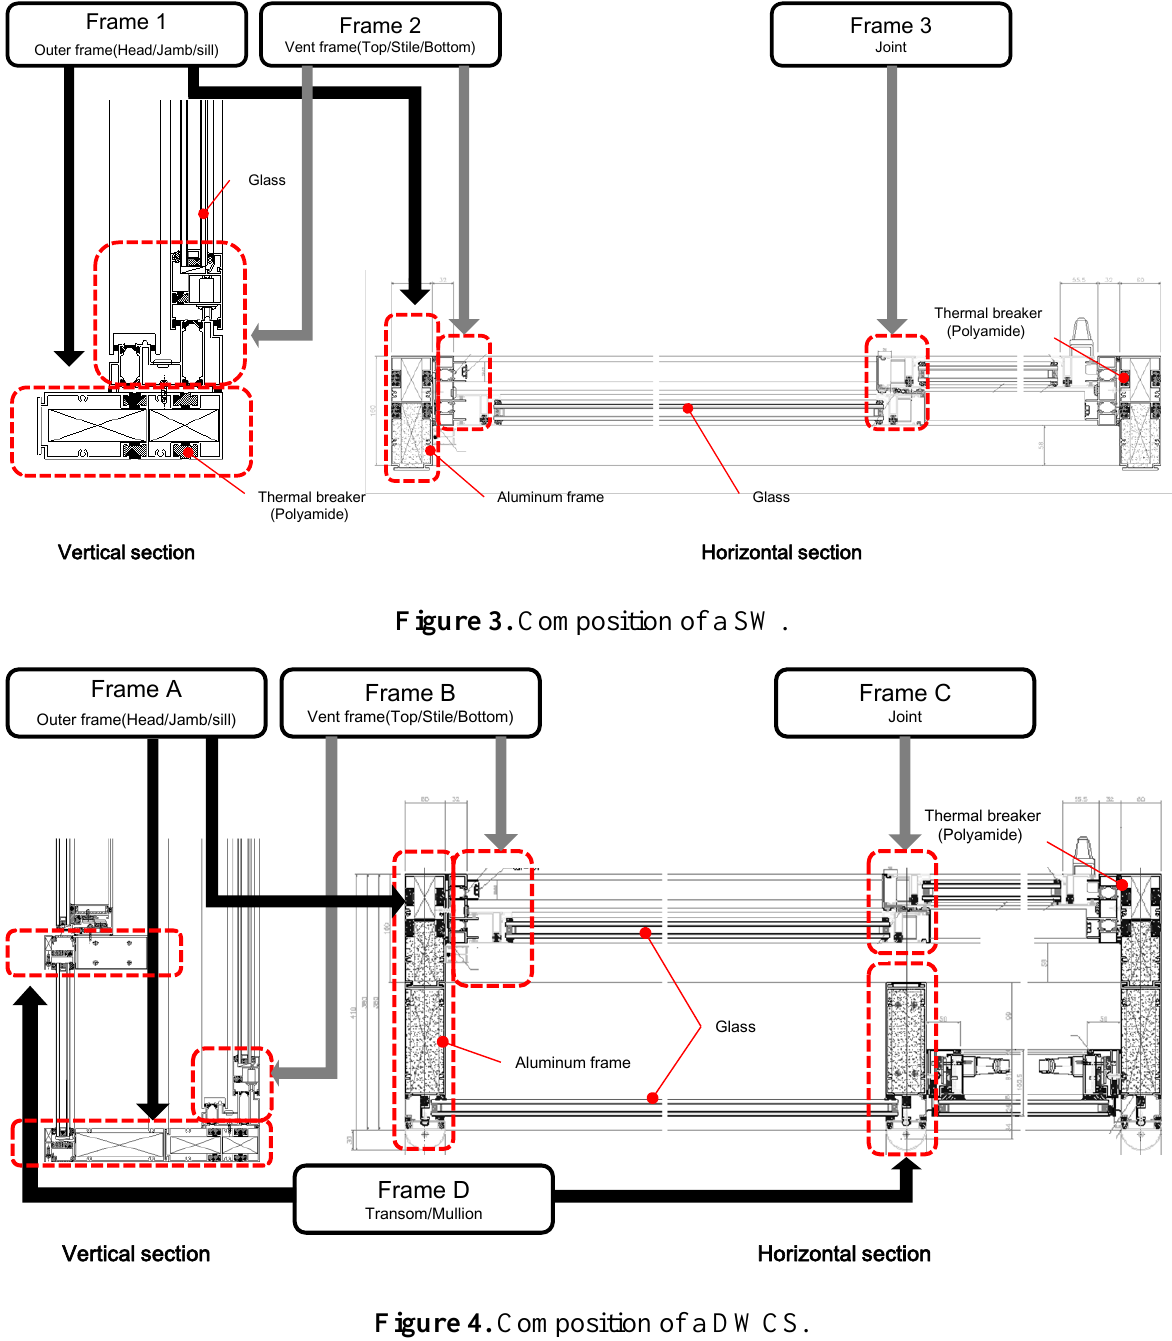
Figure 4. Composition of a